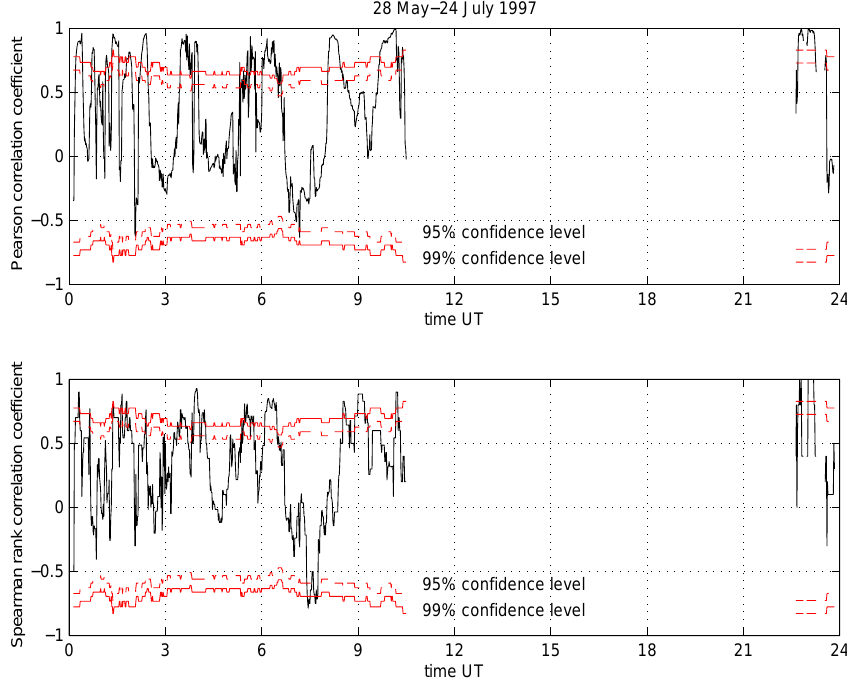
Fig. 6. Same as Fig. 3, except that the Pearson correlation coefficients and Spearman rank correlations coefficient were computed for 1-min intervals. Also, only data for which the square of absorption was greater than 1dB 2 were used when calculating the correlation coefficients.